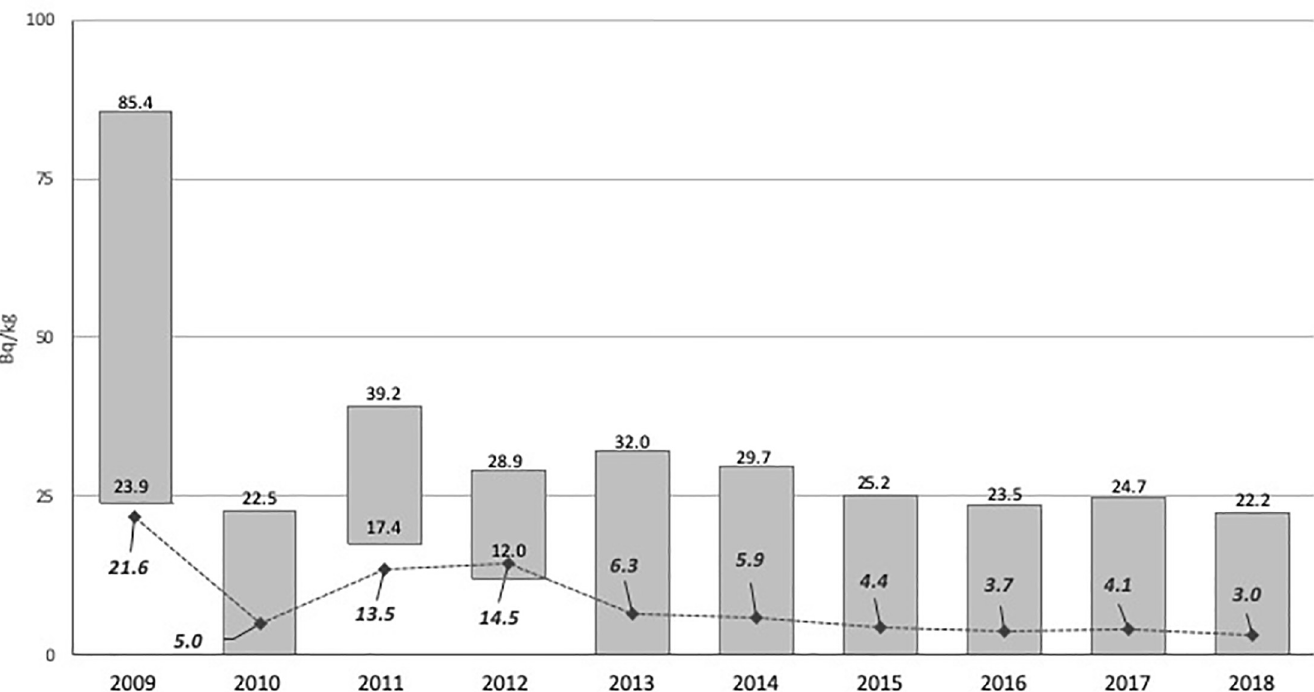
Fig 1. Mean and the 75 th and 95 th percentiles of 137 Cs concentration (Bq/kg) in the body. The top and bottom of each bar indicate the value of 137 Cs concentration in the body at the 75 th and 95 th percentiles for each year. The stretching line through the bars is the mean. The 137 Cs concentration in the body at the 75 th percentile was detectable only in 2009, 2011, and 2012, and thereafter, it had below detectable levels. The body burden decreased gradually with the progress of the study, with small fluctuations.